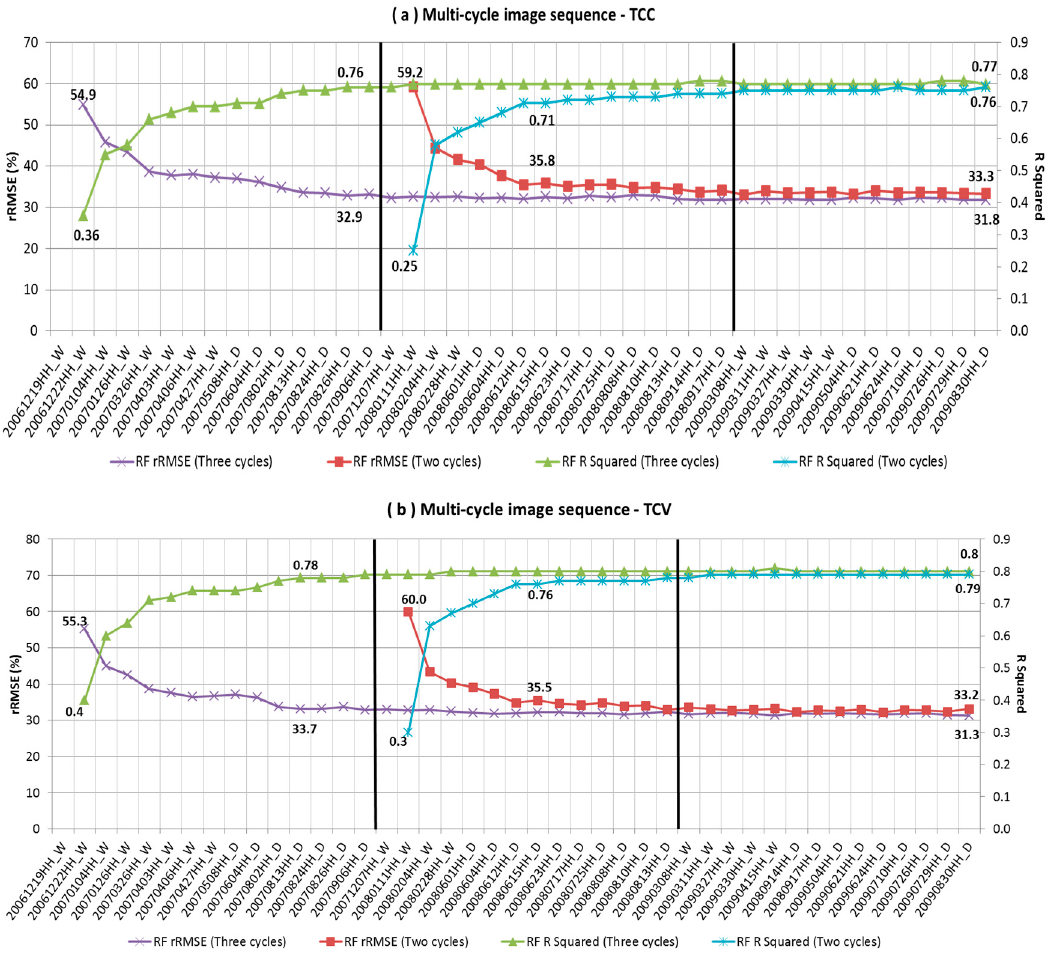
Figure 6. ( a , b ): Results from the sequential addition to the model of date ordered wet and dry images from: (i) all three cycles of images; (ii) only two cycles of images, for both TCC ( a ) and TCV ( b ) metrics. The first two images of each scenario are used as the starting combination. Data labels are provided for the first result, the approximate plateau, as well as the final result in the sequence.